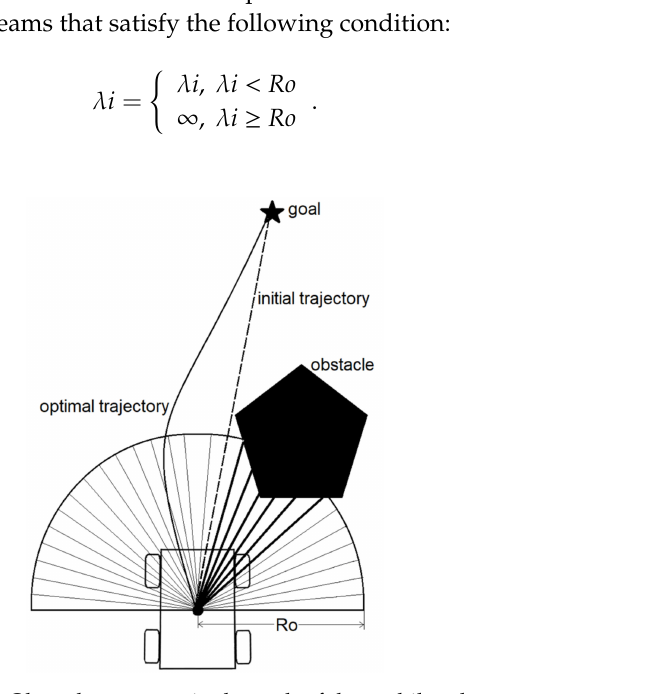
Figure 3. Obstacle presence in the path of the mobile